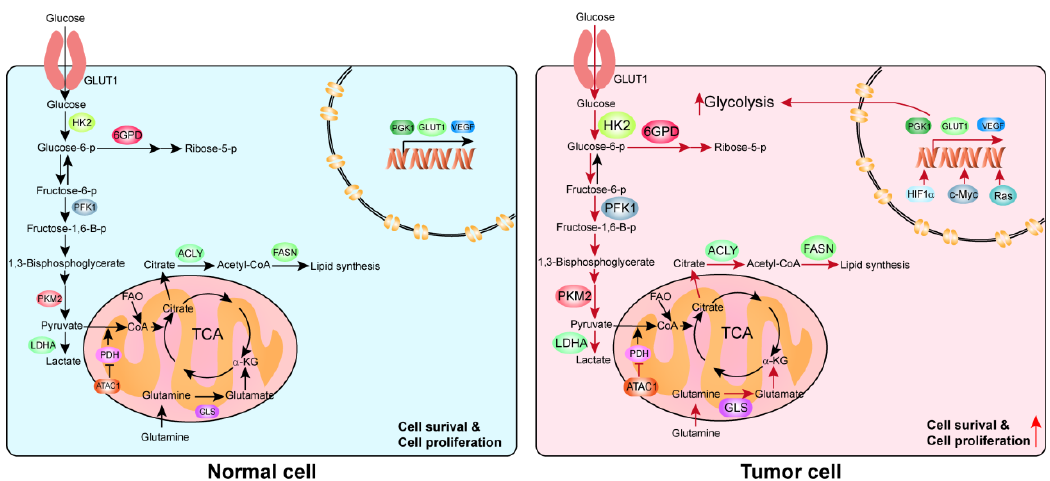
Figure 1. An overview of metabolic reprogramming in normal vs. tumor cells. This diagram depicts the major metabolic pathways in the cell. The red arrows indicate enhanced metabolic processes in cancer cells, whereas the black arrows indicate baseline levels observed in normal cells.